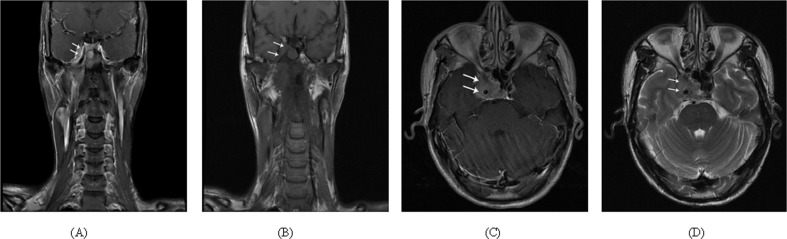
Representative appearance of cavernoussinus invasion (CSI) on multi-serial plane MRI scan images from an individual patient with NPC.(A) Enhanced coronal T1W fat-suppressed magnetic resonance (MR) image showing invasion of the right CS via the foramen lacerum (upward arrow). (B) Plain coronal T1W MR image of the same scanning plane as shown in (A). (C) The lesion is seen to extend to the right CS (arrow) and the orbital apex on the axial T1W MR image. (D) Axial T2W MR image of the same scanning plane as shown in (C).